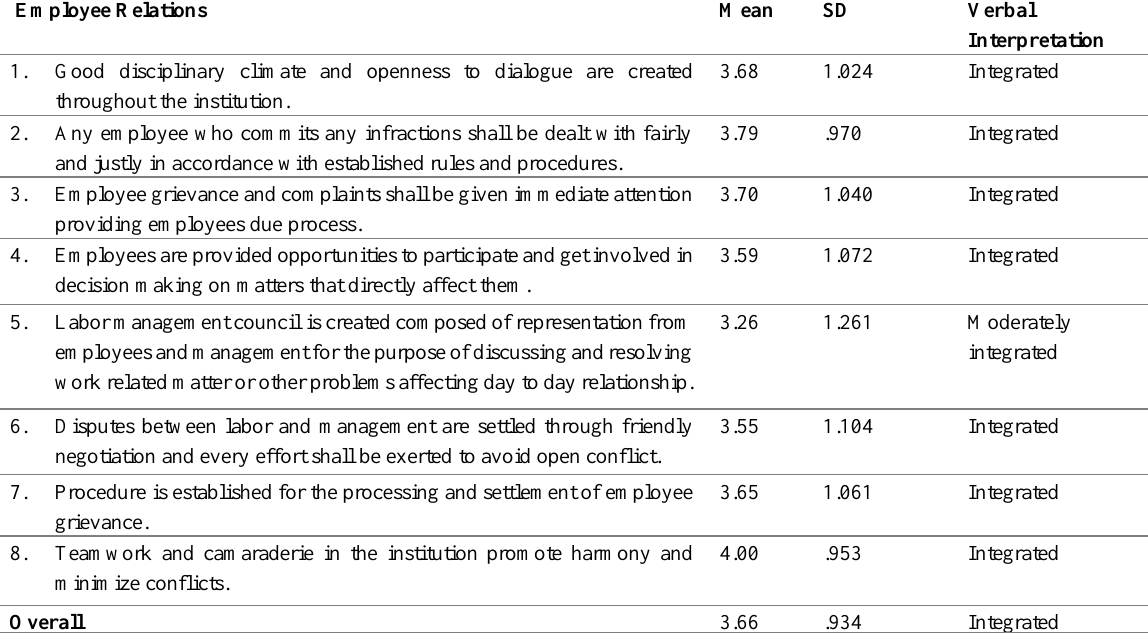
Table 1: Extent of Integration of Leadership to Employee Relations as Perceived by